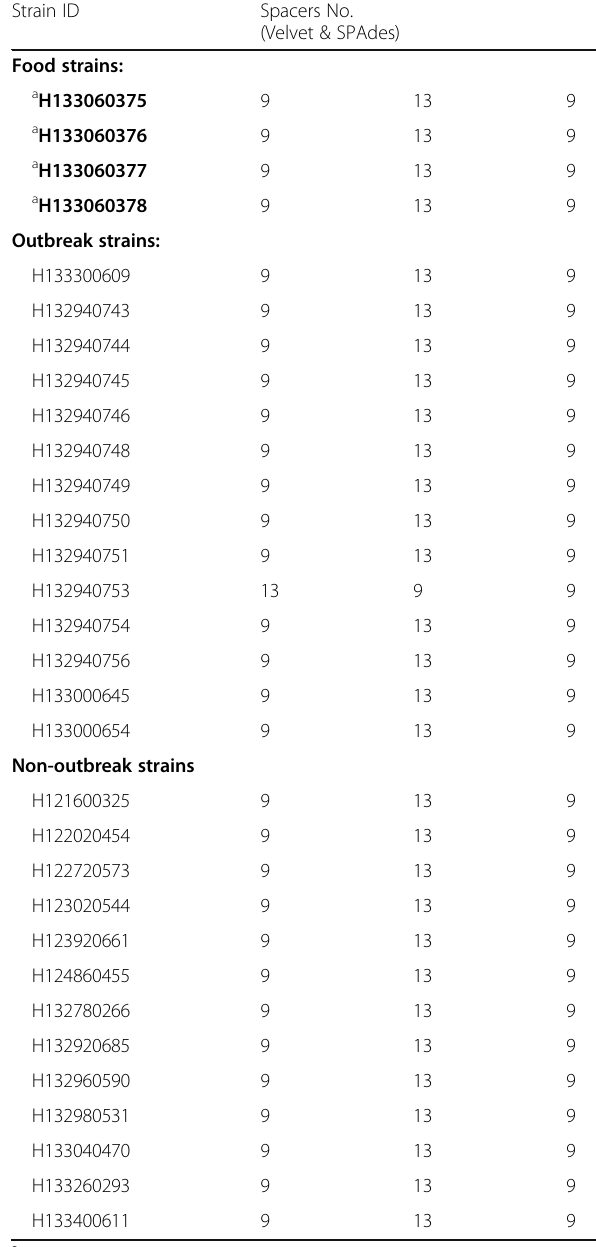
Table 4 Number of spacers within CRISPRs loci in all Salmonella Typhimurium strains analysed in this study Strain